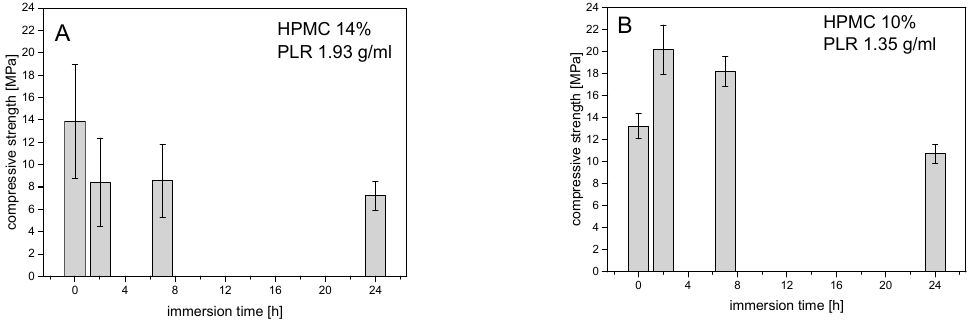
Figure 3. Compressive strength of hardened magnesium phosphate cement pastes with either ( A ) 14 wt.% HPMC (PLR 1.93 g/mL) or ( B ) 10 wt.% HPMC (PLR 1.35 g/mL) depending on the storage time of the pastes at 37 °C prior to hardening.